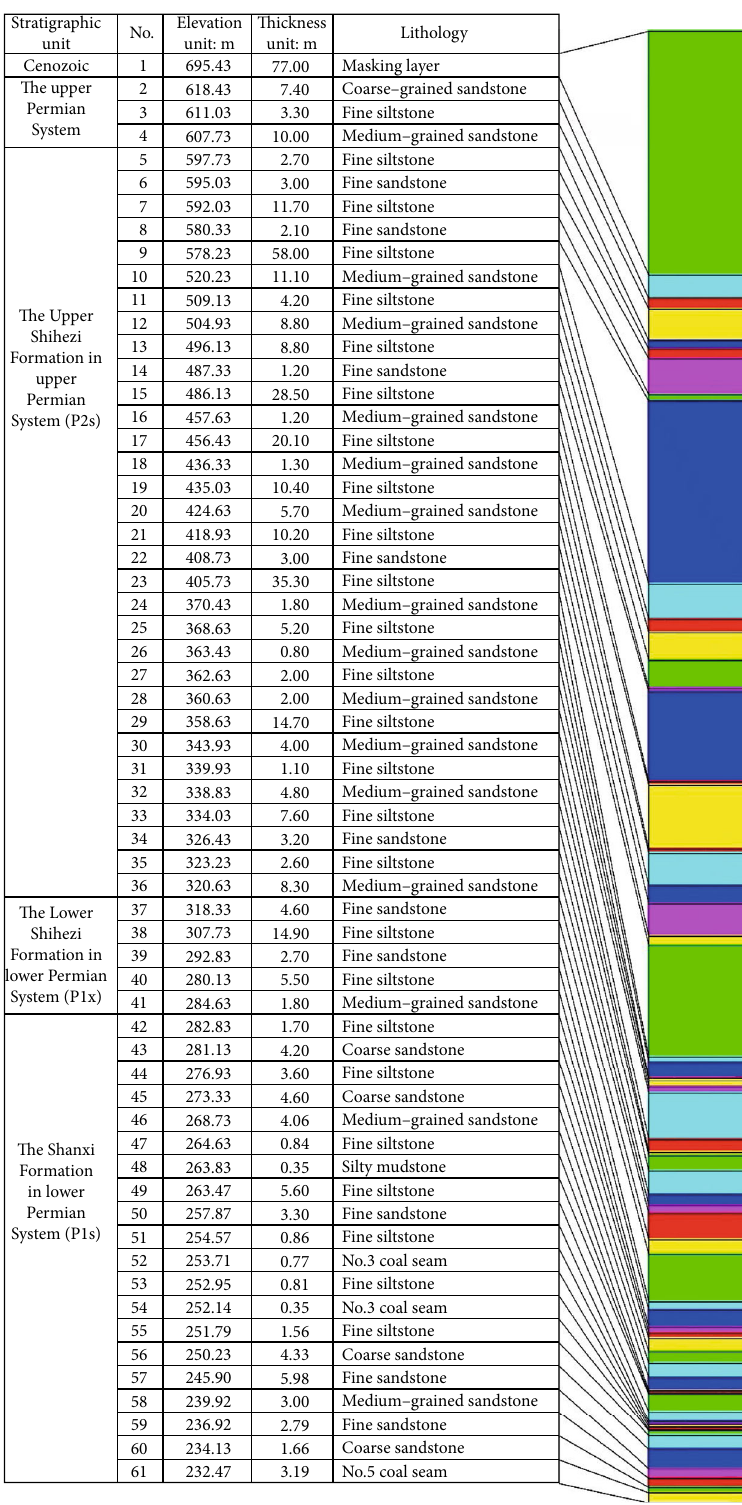
Figure 13: Drill histogram of No. 22517 working face